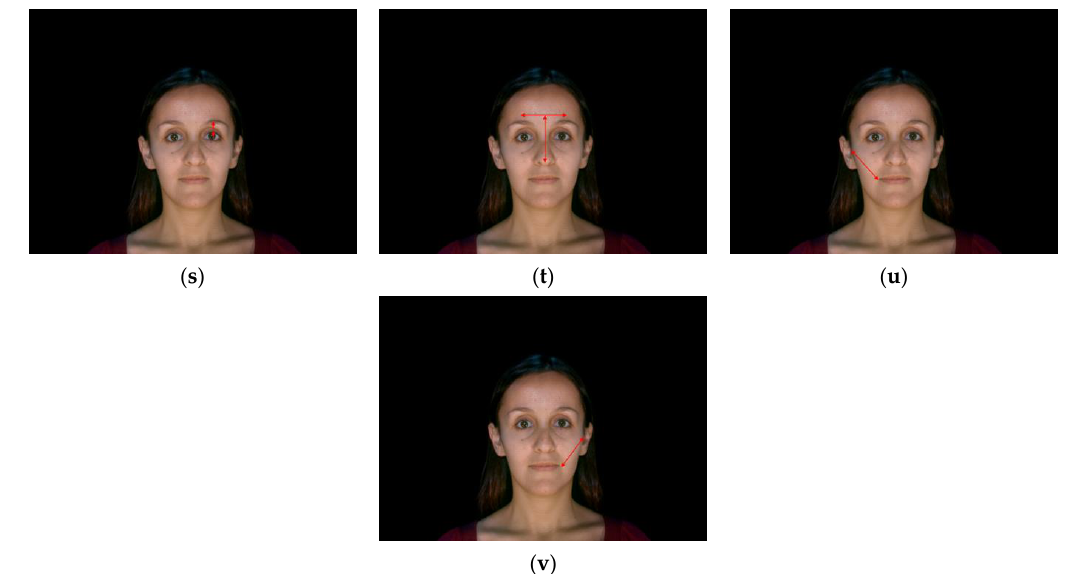
Figure 13. Illustration of the 22 facial features: ( a ) left eye width; ( b ) right eye width; ( c ) left eye position; ( d ) right eye position; ( e ) mouth width; ( f ) mouth position; ( g ) nose width; ( h ) nose position; ( i ) chin width; ( j ) chin position; ( k ) forehead width; ( l ) forehead position; ( m ) distance between eyes; ( n ) distance between left eye and nose; ( o ) distance between right eye and nose; ( p ) distance between left eye and mouth; ( q ) distance between right eye and mouth; ( r ) distance between left eye and eyebrow; ( s ) distance between right eye and eyebrow; ( t ) distance between nose and forehead; ( u ) distance between left ear and mouth; ( v ) distance between right ear and mouth.